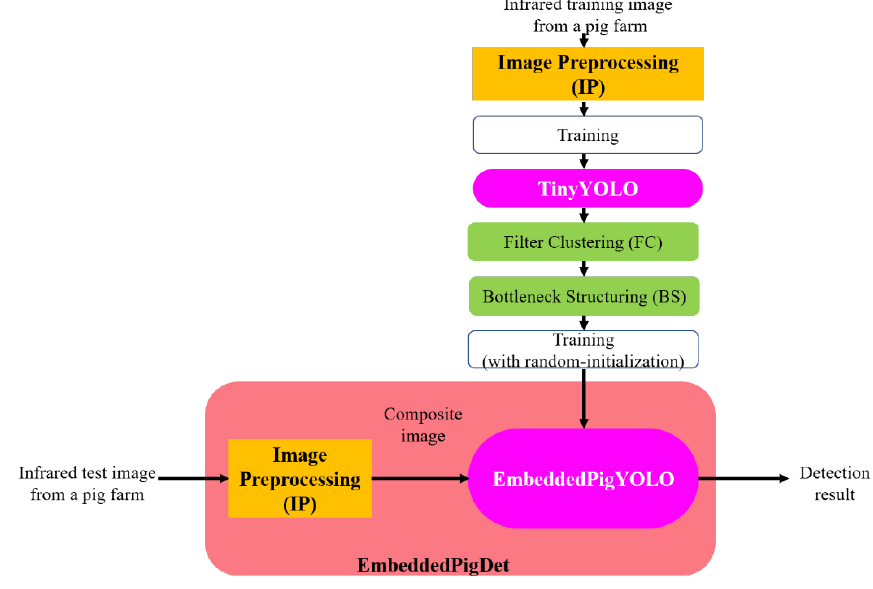
Figure 2. Overview of the proposed method EmbeddedPigDet consisting of image preprocessing (IP), filter clustering (FC) and bottleneck structuring (BS).